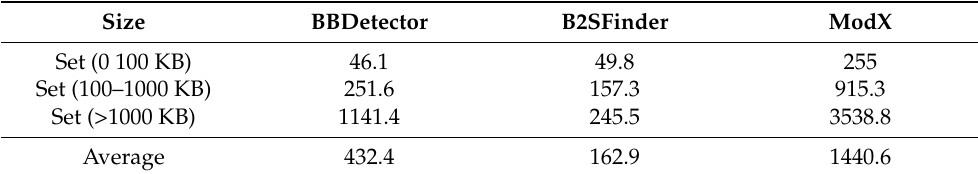
Table 6. The average detection time of TPL detection for nix binary dataset(s).